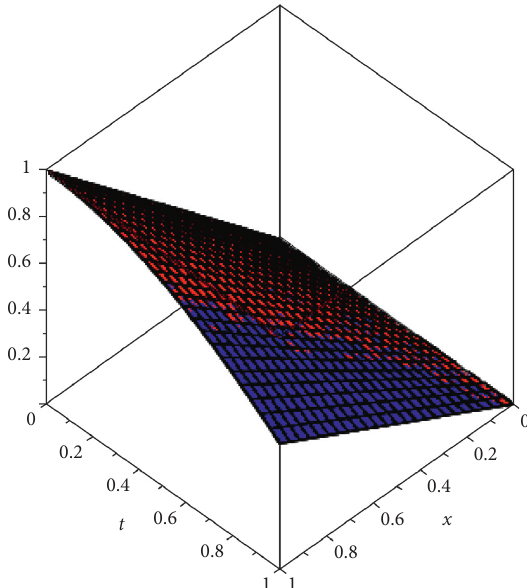
Figure 4: Comparison of the exact solution (blue) and the ap- proximate solutions (red) of Example 4.